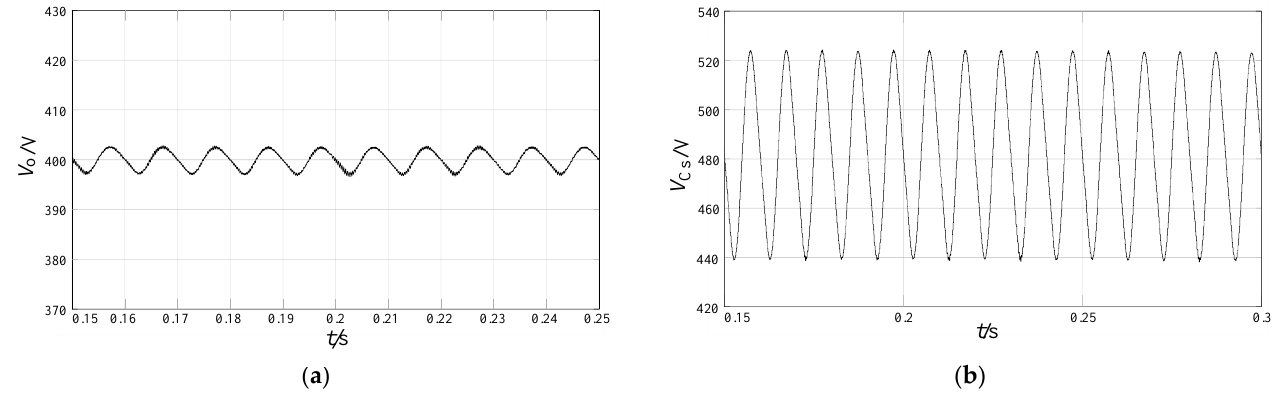
Figure 14. The output voltage waveforms of the bridgeless PFC converter and power decoupling circuit: ( a ) output voltage ripple; ( b ) power decoupling capacitor voltage. As shown in Figure 15a,b, the output voltage fluctuates when the load changes. It can be seen from the figure that when the load changes from full load to half load and load changes from half load to full load, the output voltage can be restored to a stable state within 0.02 s, and the voltage does not fluctuate significantly when the load changes. Fig- ure 15c,d are the waveforms of the output current when the load changes abruptly. The current can reach stability quickly after the load changes, so the dynamic response speed of the system is fast and the dynamic stability is strong.